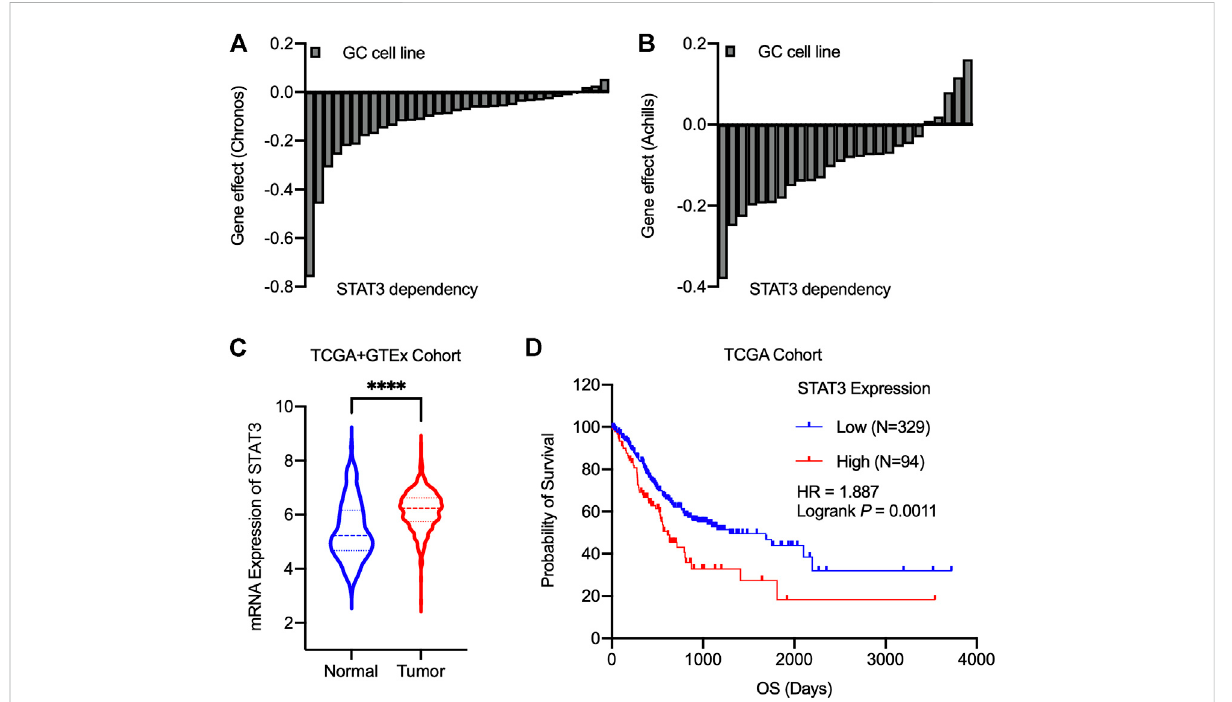
FIGURE 1 STAT3 serves as an essential gene for gastric cancer, and its overexpression correlates with poor prognosis. (A,B) The Chronos dependency scoreusingCRISPR/Cas9 (A) andAchillesdependencyscoreusingRNAi (B) fromcancercelllines.Ascoreof0indicatesageneisnotessential,anda lower score indicates a higher likelihood that the gene is essential in a given cell line. (C) mRNA Expression levels of STAT3 for the normal and tumor samples.StatisticsanalysiswasdoneusingunpairedStudent ’ s t -test.**** p < 0.0001. (D) TCGAsurvivalanalysisforgastriccancerpatientsbased on STAT3 expression levels. Logrank test was performed for the statistical